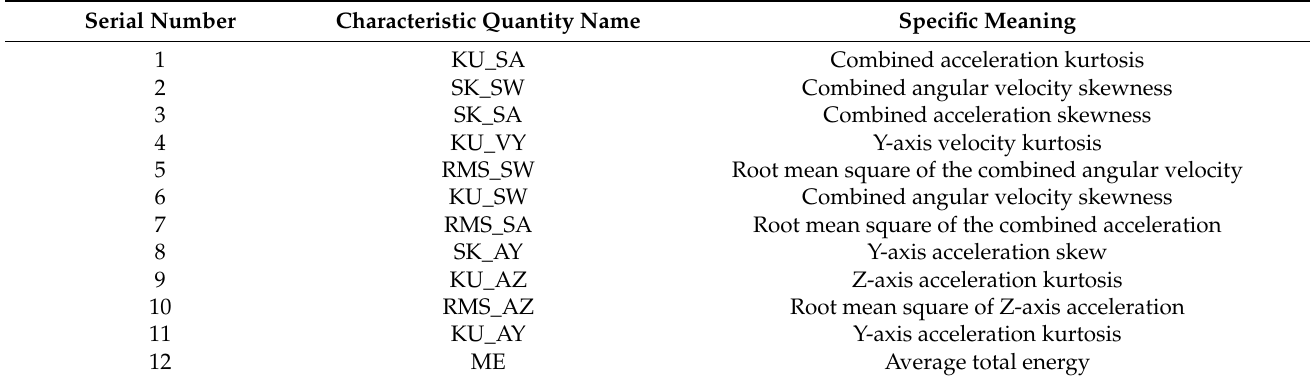
Table 4. Explanation of main characteristic parameters.